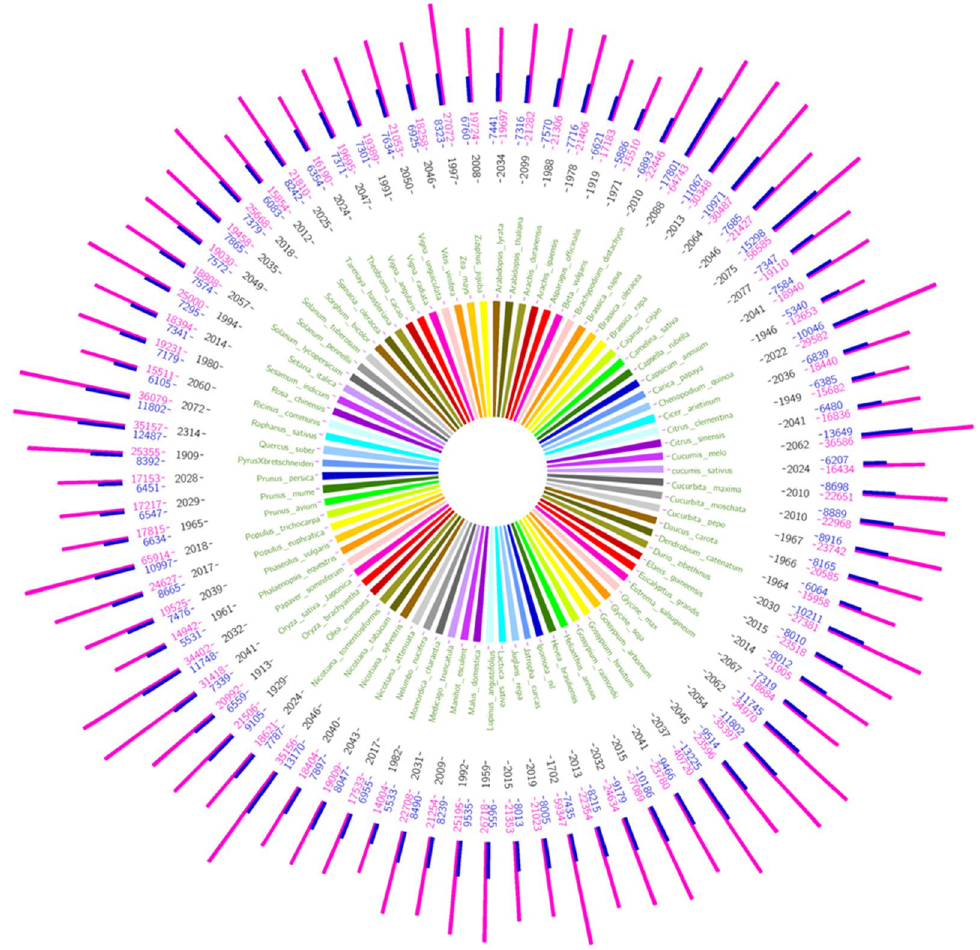
Figure 6. Statistical layout of the 82 analyzed plant genomes. The middle part shows the plants’ scientific names (each plant is assigned to a unique color). The black-colored numbers refer to the number of mapped enzymes within each plant genome, where the blue-colored numbers refer to the number of developed PGTMs, and the purple-colored numbers refer to the number of developed